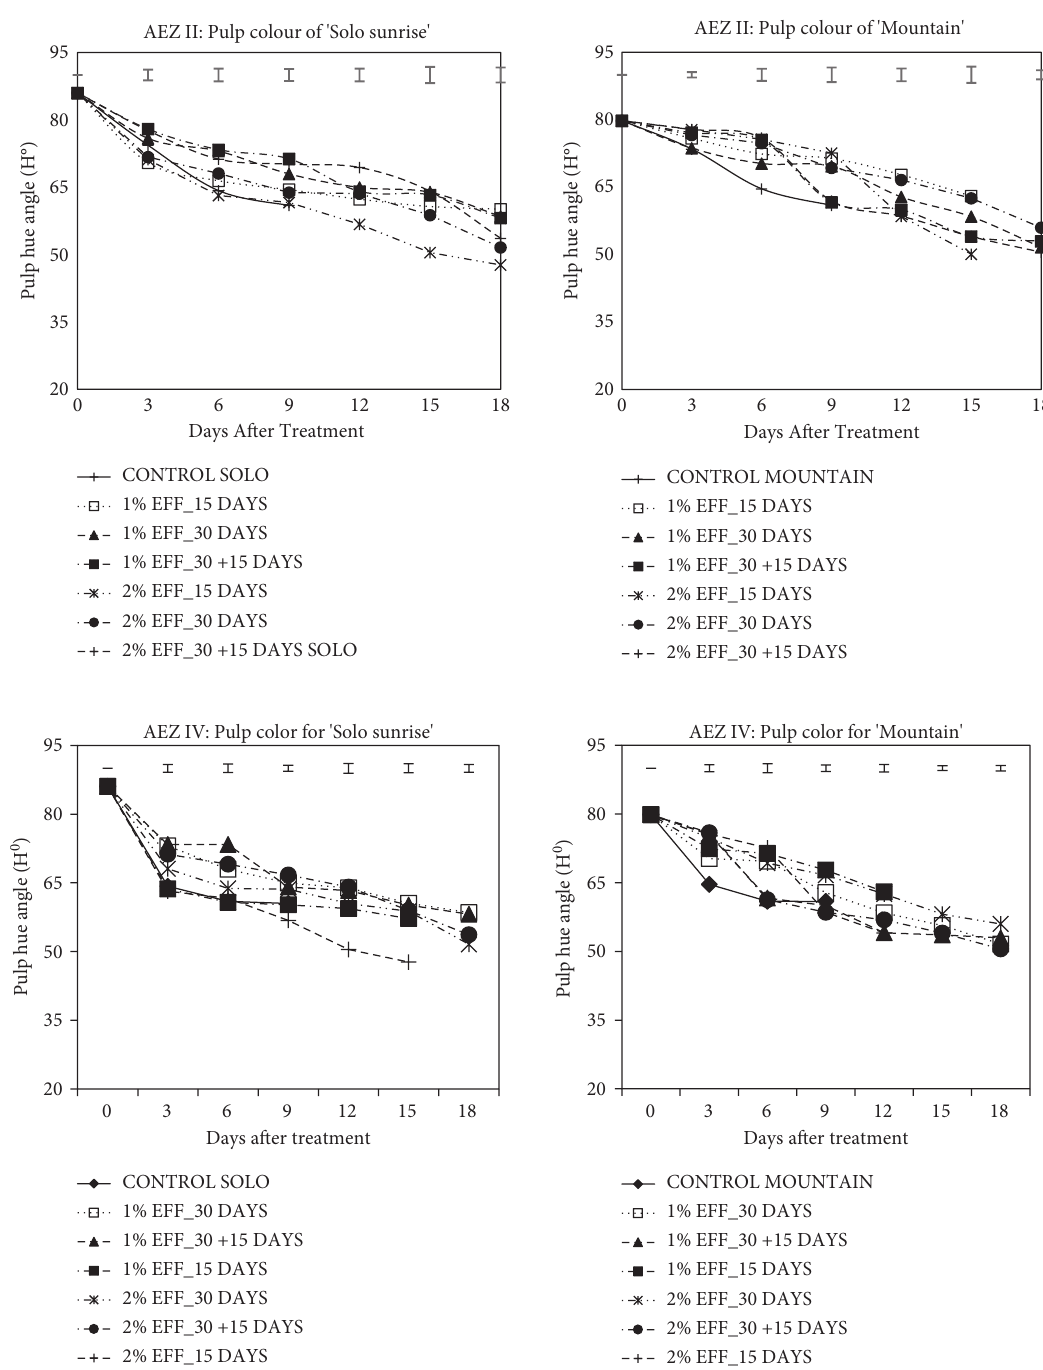
Figure 3: Papaya pulp color (H ° ) for Hexanal sprayed fruits from Machakos and Meru counties. Top bars represent LSD at